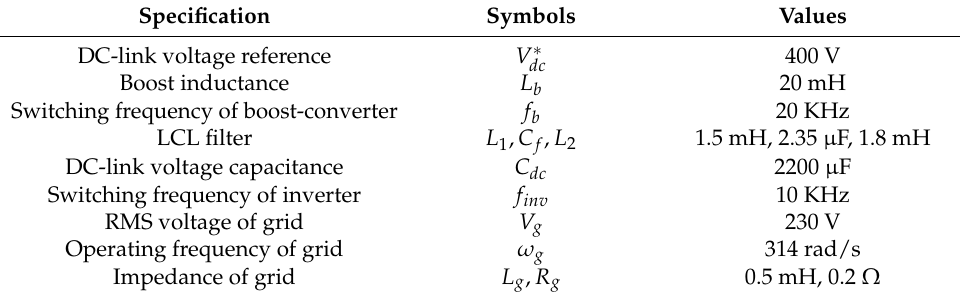
Table 1. Nominal values of proposed grid-connected PV